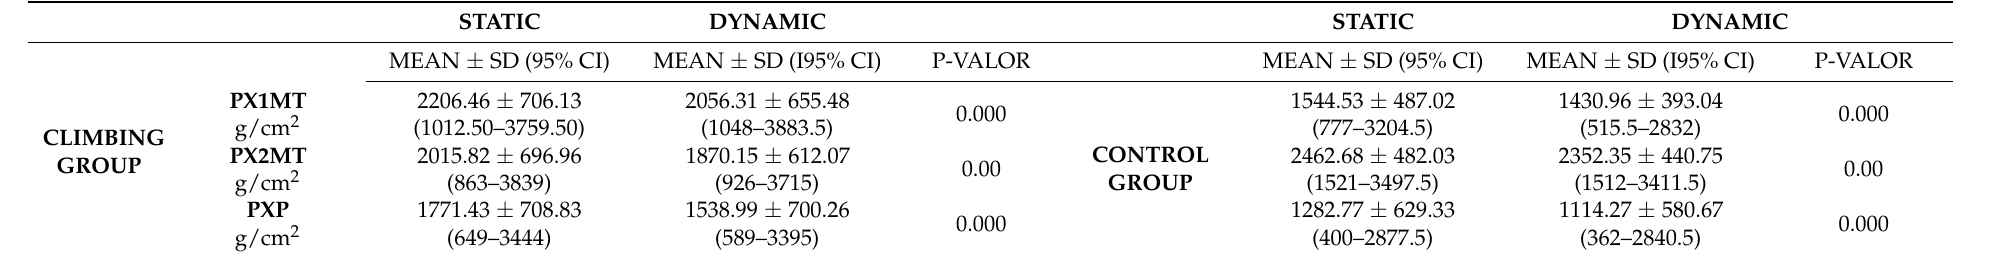
Table 3. Maximum static and dynamic